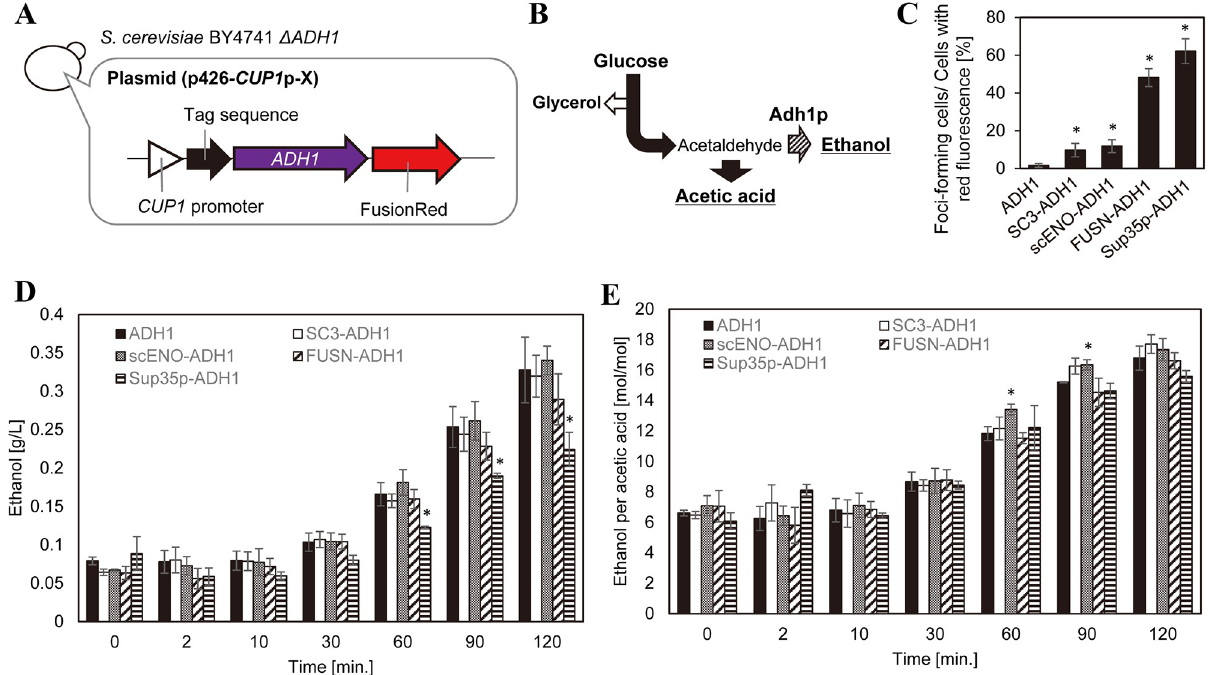
Fig 4. Effect of Adh1p localization in cells on cellular metabolism under hypoxia. A: Overview of constructed yeast strains. ADH1 was fused with tag sequences (SC3, scENO, FUSN, or Sup35p) and FusionRed then expressed in response to 100 μ M Cu 2+ using the CUP1 promoter. As a control, ADH1 was fused with FusionRed and expressed using the CUP1 promoter. Within the genome of the host strain ( adh1 Δ ), ADH1 was knocked out by homologous recombination using the kanamycin resistance gene. B: Simplified illustration of glucose metabolism. Most (11 out of 12) enzymes shown to form META bodies under hypoxia are components of the metabolic pathway converting glucose to acetic acid (black arrow). Enzymes catalyzing the production of glycerol (white arrow) do not form condensates. The metabolic reaction catalyzed by Adh1p converts acetaldehyde to ethanol (shaded arrow). Metabolites predicted to be affected the subcellular localization of Adh1p are underlined. C: Proportions of foci-forming cells for each transformant. ADH1, S . cerevisiae BY4741 adh1 Δ transformed with p426- CUP1 p-Adh1p-FusionRed; X-ADH1, S . cerevisiae BY4741 adh1 Δ transformed with p426- CUP1 p-X-Adh1p-FusionRed. n = 3. Error bars show standard deviations. * : P < 0.05 compared with cells transformed with ADH1. D: Ethanol concentration in culture media. E: Ratio of ethanol to acetic acid concentrations in culture media. D and E: black bars, ADH1; white bars, SC3-ADH1; gray bars, scENO-ADH1; shaded bars, FUSN-ADH1; horizontal striped bars, Sup35p-ADH1. n = 3. Error bars show standard errors. * : P < 0.05 compared with cells transformed with ADH1.